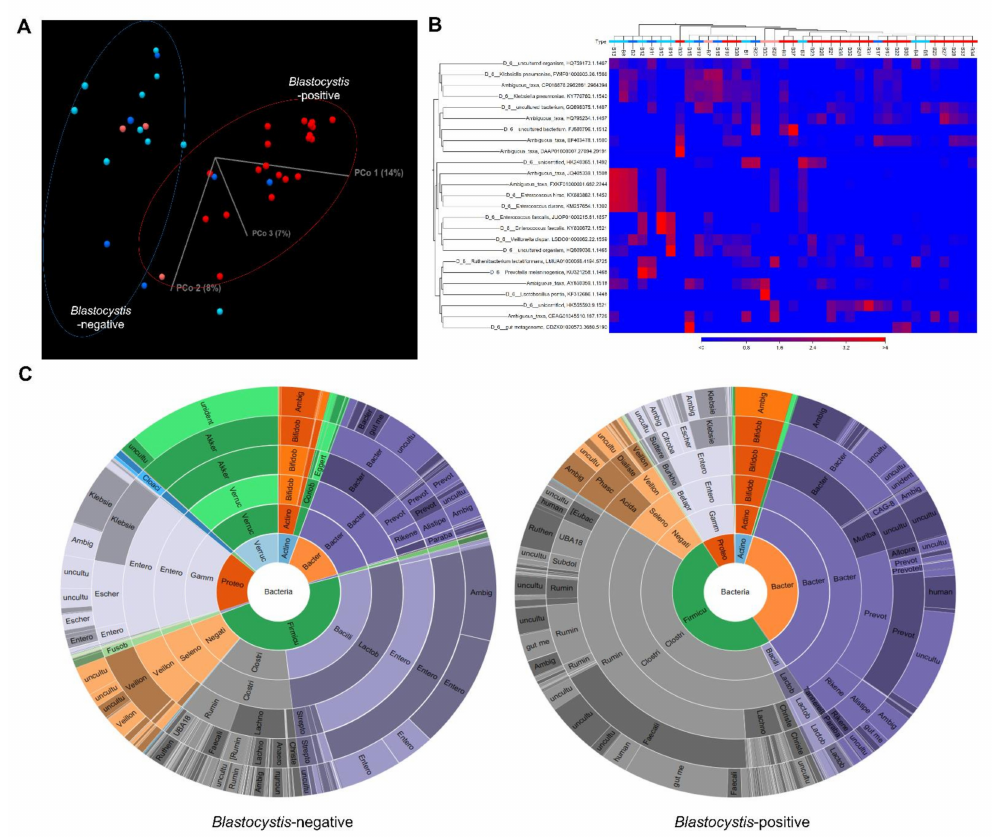
Figure 2. Gut microbiome composition according to Blastocystis colonization. ( A ) Unweighted beta diversity analysis showed that the overall bacterial community structure and phylogenetic diversity of the Blastocystis -negative (blue and sky-blue) and Blastocystis -positive (red and orange) groups were distinct. Blue dots: non-diarrheal Blastocystis -negative samples; sky-blue dots: diarrheal Blastocystis -negative samples; red dots: non-diarrheal Blastocystis -positive samples; orange dots: diarrheal Blastocystis -positive samples. ( B ) Heatmap showing operational taxonomic unit abundance in the Blastocystis -negative (blue) and Blastocystis -positive (red) groups. ( C ) Of note, the Clostridia class and the Ruminococcaceae family were more abundant in the Blastocystis -positive group, while the Bacilli class and the Enterobacteriaceae family were noticed in the Blastocystis -negative